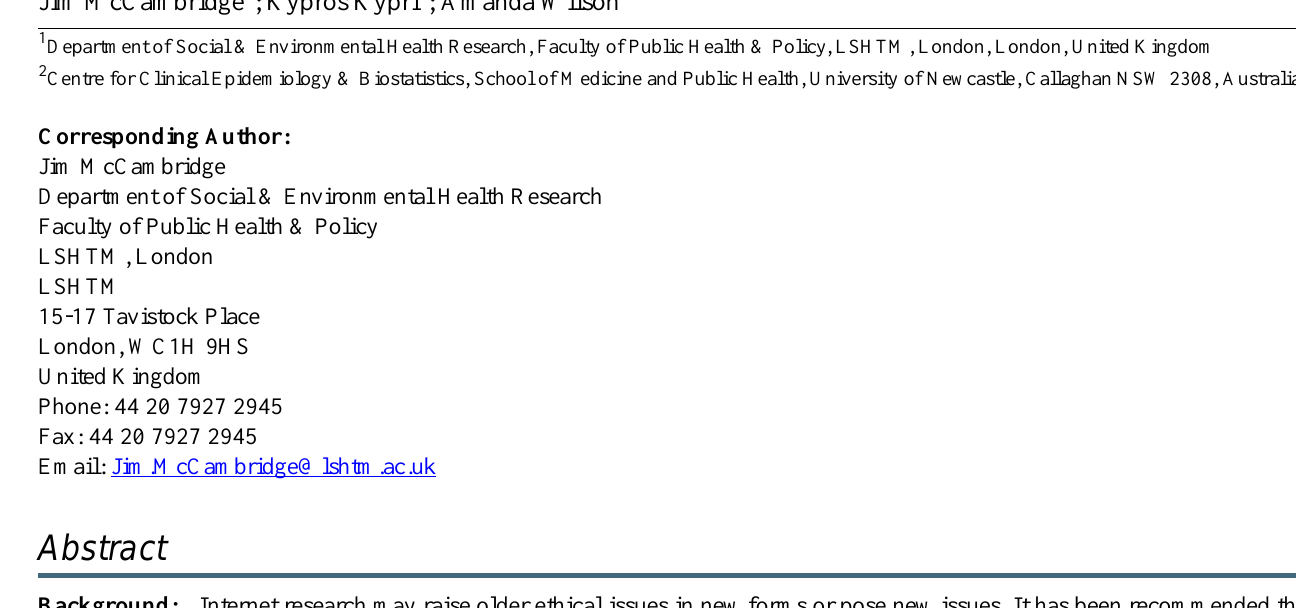
ethics; debriefing; deception; online; web-based; randomised controlled trial;